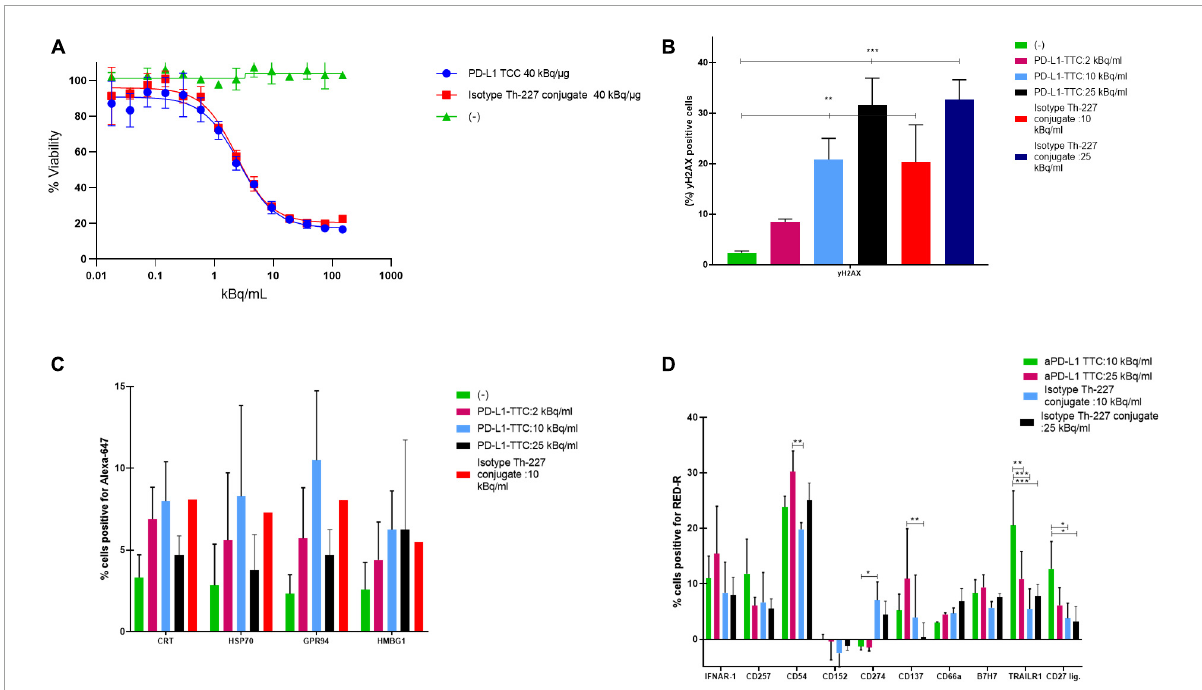
FIGURE1 (A) Cell viability of MC-38 treated for 7 days with indicated targeted thorium-227 conjugates (TTC) or cold conjugate. (B) MC-38 cells (%) positive for yH2AX by flow cytometry staining after 7 days of treatment with indicated TTC or cold conjugate. (C) MC-38 cells (%) positive for four common DAMPs by flow cytometry after 7 days of treatment with indicated TTC or cold conjugate. (D) MC-38 cells (%) positive for 10 additional DAMPs by flow cytometry after 7 days of treatment with indicated TTC or cold conjugate. Tukey’s multiple comparison test, * p < 0.05, ** p < 0.01, *** p <